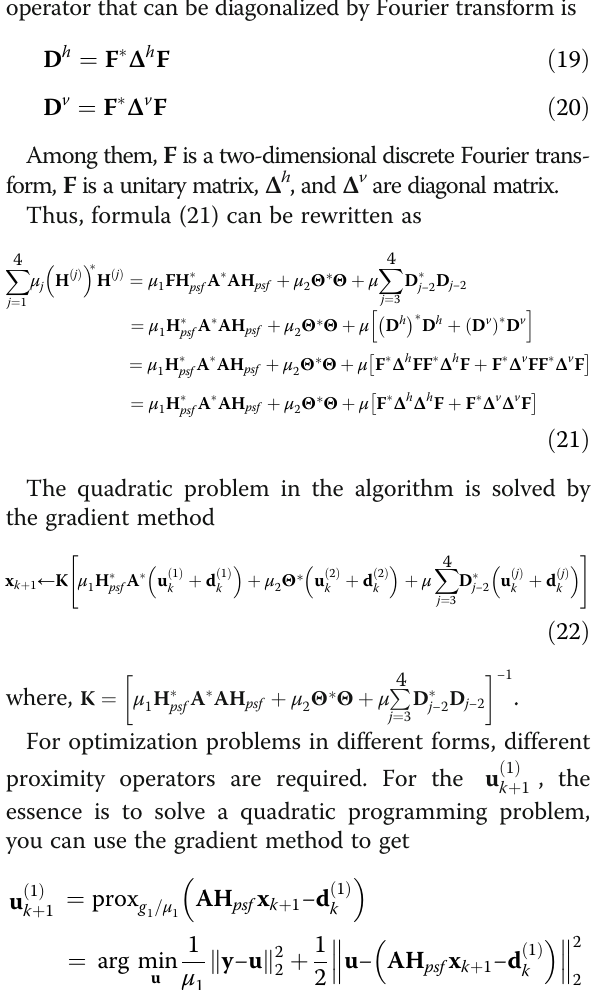
Table 2 Comparison of image evaluation parameters of different reconstruction algorithms (SNR = 40 dB) TV regularization The proposed method